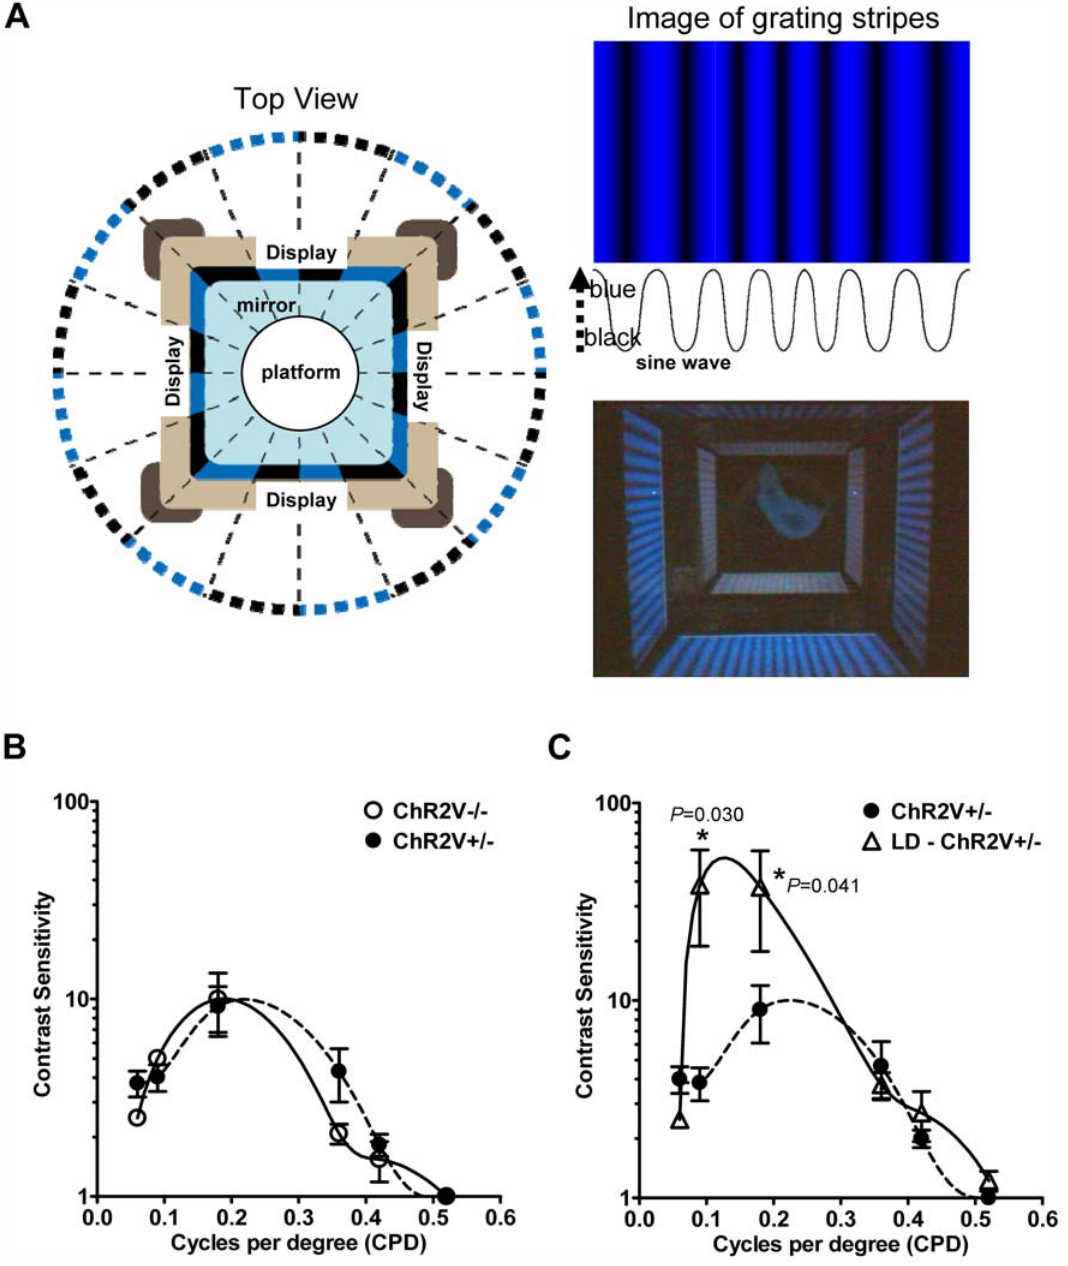
Figure 8. Optomotor response of the ChR2V 2 / 2 and ChR2V + / 2 rats. (A) The experimental design for the evaluation of optomotor response. The moving vertical stripes were displayed on the computer monitors so that the brightness-darkness contrast followed a sine-wave function of variable amplitude and spatial frequency. (B)The contrast sensitivity-spatial frequency relationship of the ChR2V 2 / 2 and ChR2V + / 2 rats before photoreceptor degeneration. (C) The contrast sensitivity-spatial frequency relationship of the ChR2V + / 2 rats after photoreceptor degeneration. LD = Light damaged. Error bars represent standard error of the mean (n=8, *: P , 0.05, Mann-Whitney U-test).